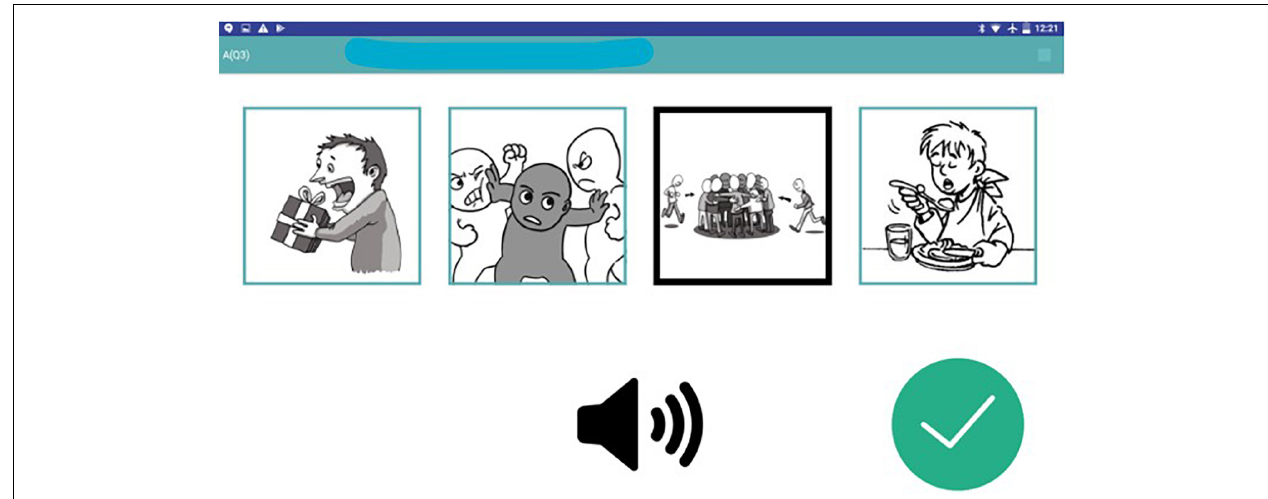
FIGURE 1 | Example of the receptive vocabulary assessment application interface for the verb rejoindre